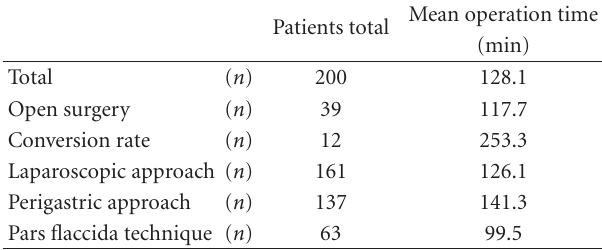
Table 2: Operation data.